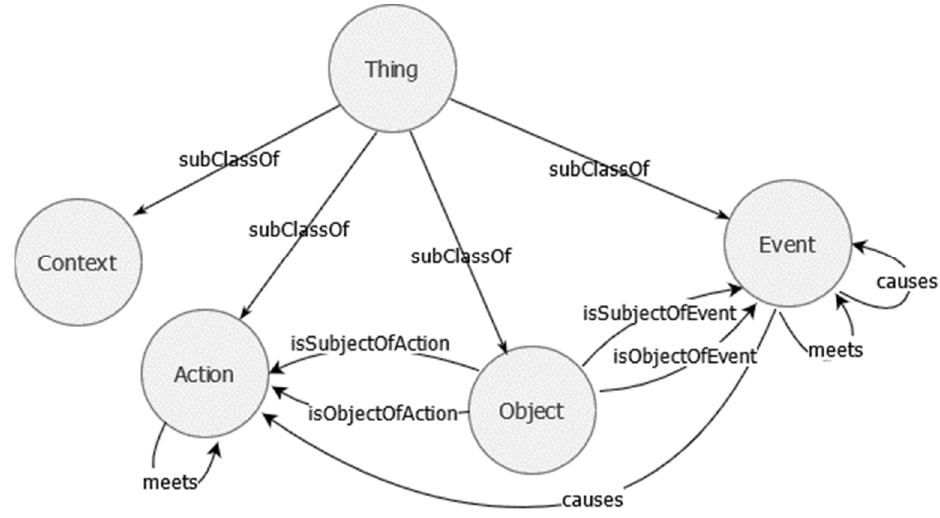
Figure 1. Schema of the domain model of AGO showing core concepts and main relationship types.